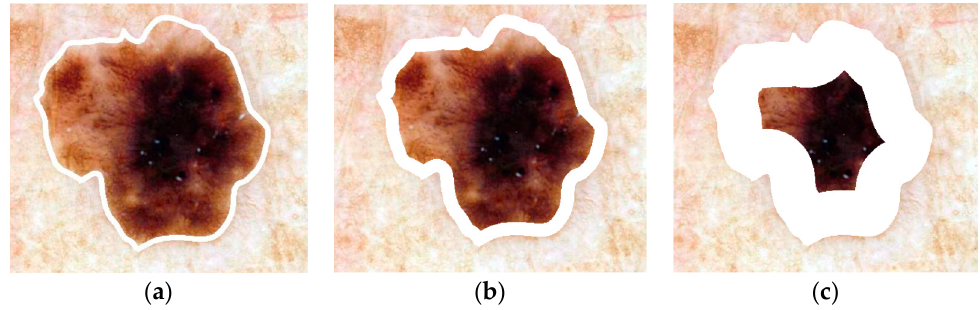
Figure 3. Boundary area percentage examples using 10% ( a ), 25% ( b ) and 75% ( c ) of the lesion area for analysis (white region). (This is the same lesion as in Figure 1).